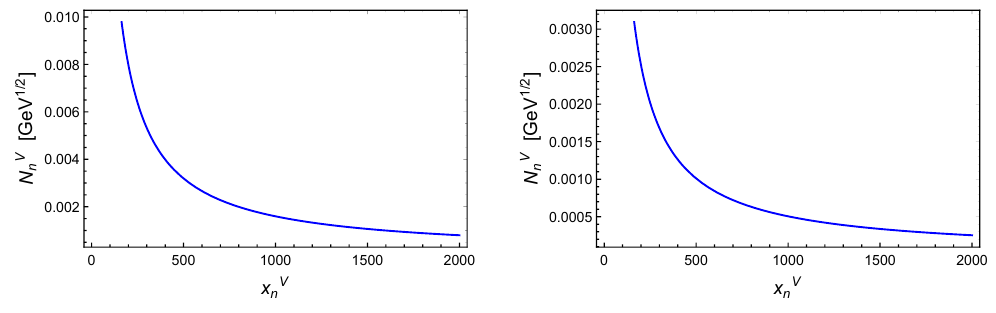
Figure 1 . Normalization N V as a function of x V , for BM II (left) and IV (right) with (cid:14) A = (cid:14) B = 1 n n and (cid:11) = 1 GeV. BM I (III) presents basically the same behavior as BM II (IV) which are not shown.